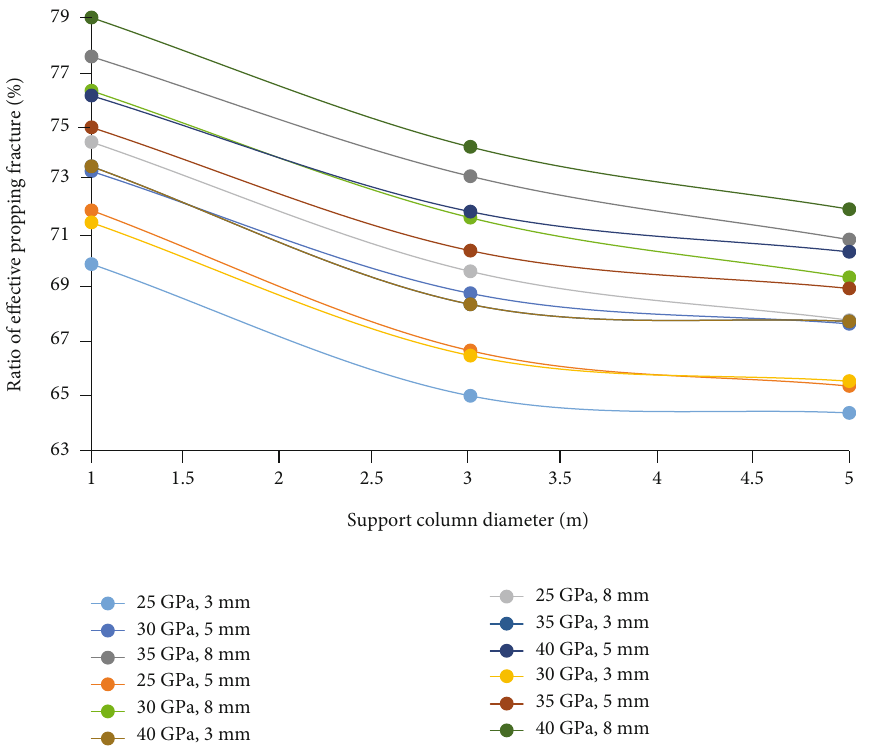
Figure 45: The e ff ect of proppant diameter on the ratio of e ff ective supporting fractures (in situ stress 50 MPa).